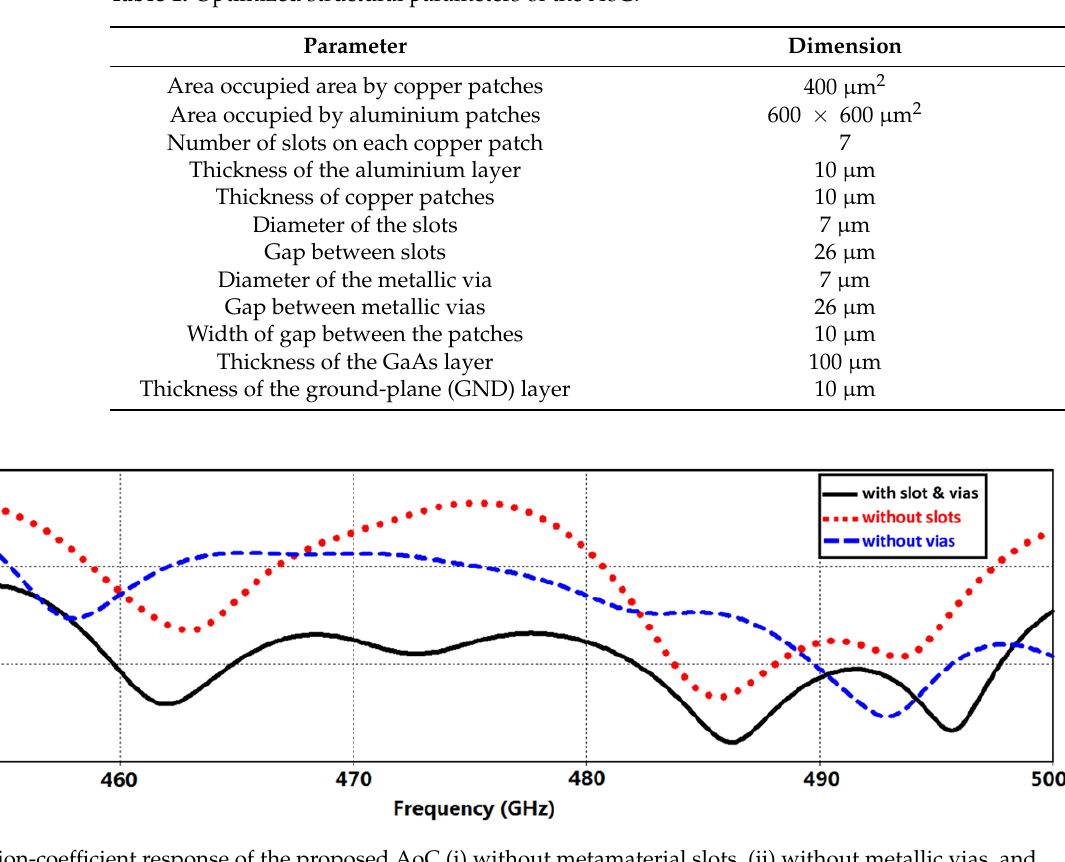
Table 1. Optimized structural parameters of the AoC.